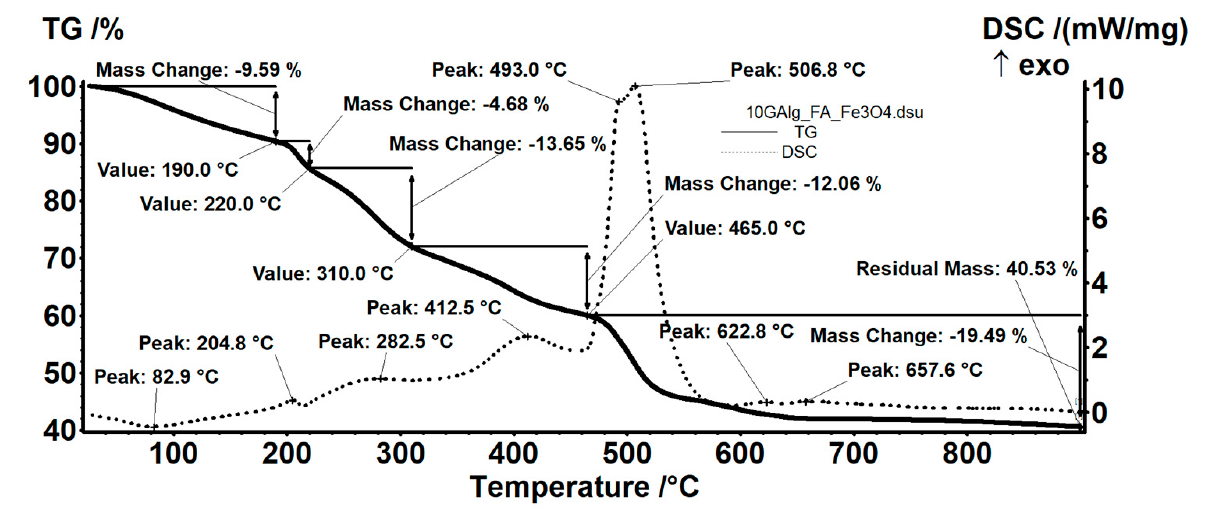
Figure 8. Thermal analysis of room temperature-dried 10G/Alg/FA/Fe 3 O 4 film.